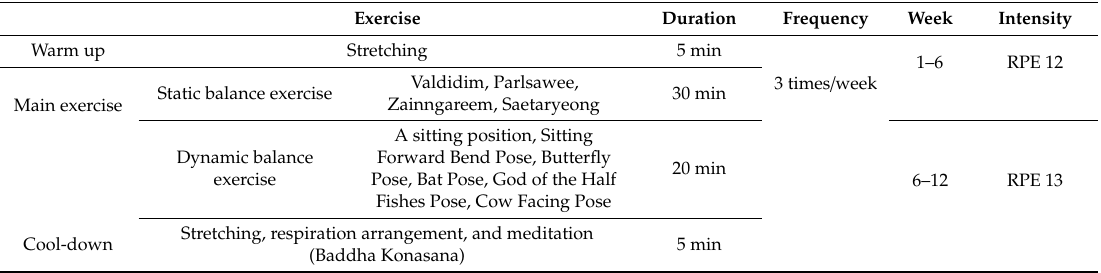
Table 1. Description of the combined exercise program performed by the exercise group. Exercise Duration Frequency Week Intensity Warm up Stretching 5 min 1–6 RPE 12 3 times / week